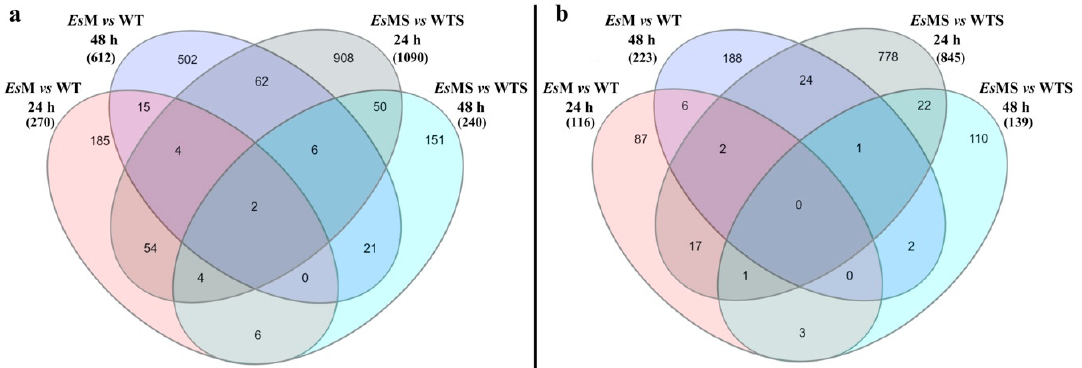
Figure 3. Venn diagram showing the differentially expressed genes (>2-fold up- and down-regulated) in the mannitol transgenic line vs. wild type, in standard ( Es M and WT, respectively) and salinity stress conditions ( Es MS and WTS, respectively), at 24 and 48 h. ( a ) genes that were >2-fold up-regulated, ( b ) genes that were >2-fold down-regulated.